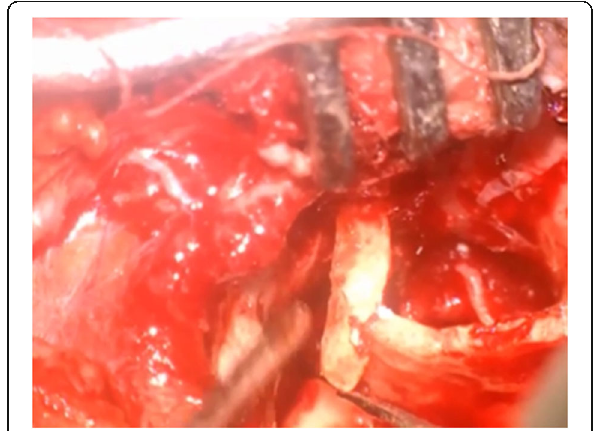
Fig. 1 Reconstruction of the canal wall with bone